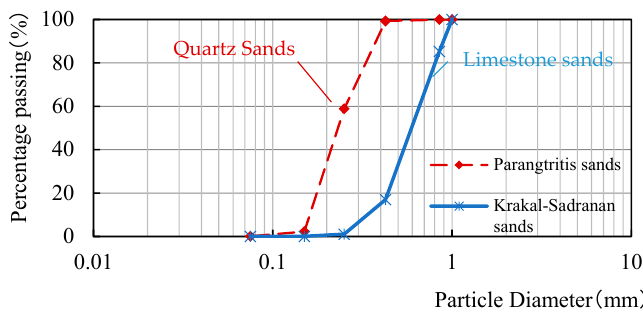
Table 2. Standard composition of cementation solution 0.5 M (solvent in artificial seawater).